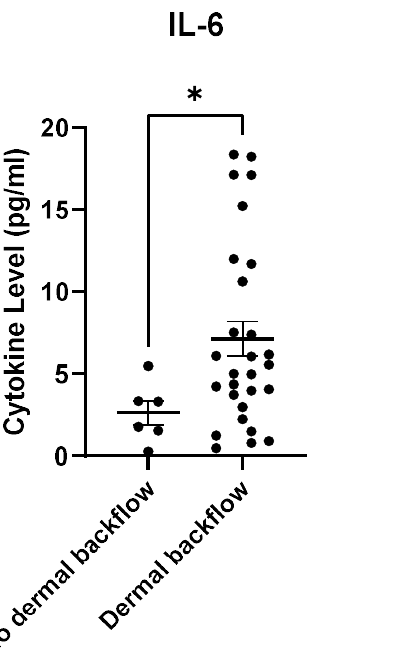
Figure 5. Pre-ALND IL-6 and MIP-1β plasma levels were higher in subjects displaying dermal back- flow at 12-months post-RT. * p ≤ 0.05, ** p ≤ 0.01.